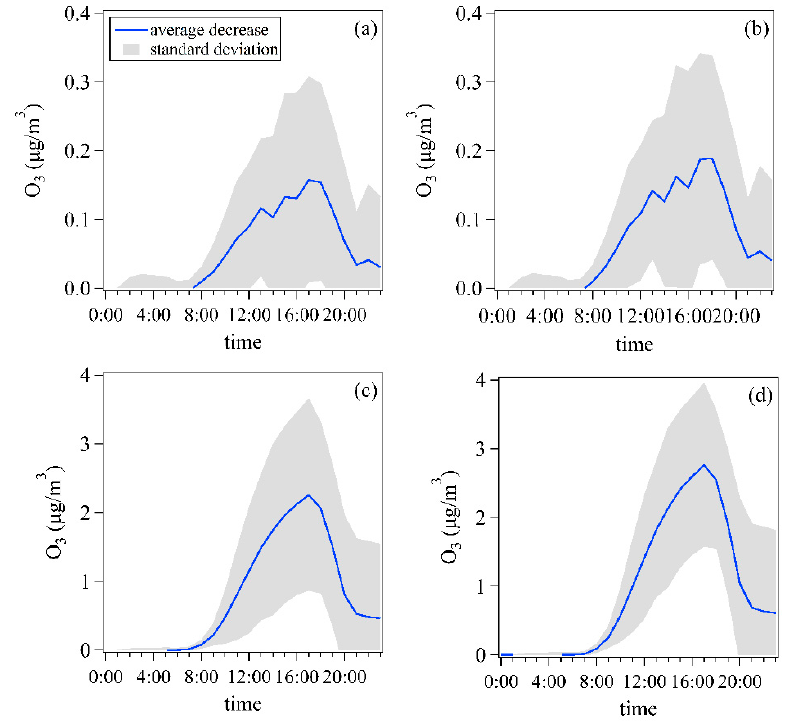
Figure 12. Average diurnal variation patterns of decreases for O 3 concentrations simulated by the observation-based model (OBM) for all days and non-attainment days in 1 May–15 June 2020. ( a ) the scenario 1 versus baseline scenario for all days, ( b ) the scenario 1 versus baseline scenario for non-attainment days, ( c ) the scenario 2 versus baseline scenario for all days, ( d ) the scenario 2 ver- sus baseline scenario for non-attainment days